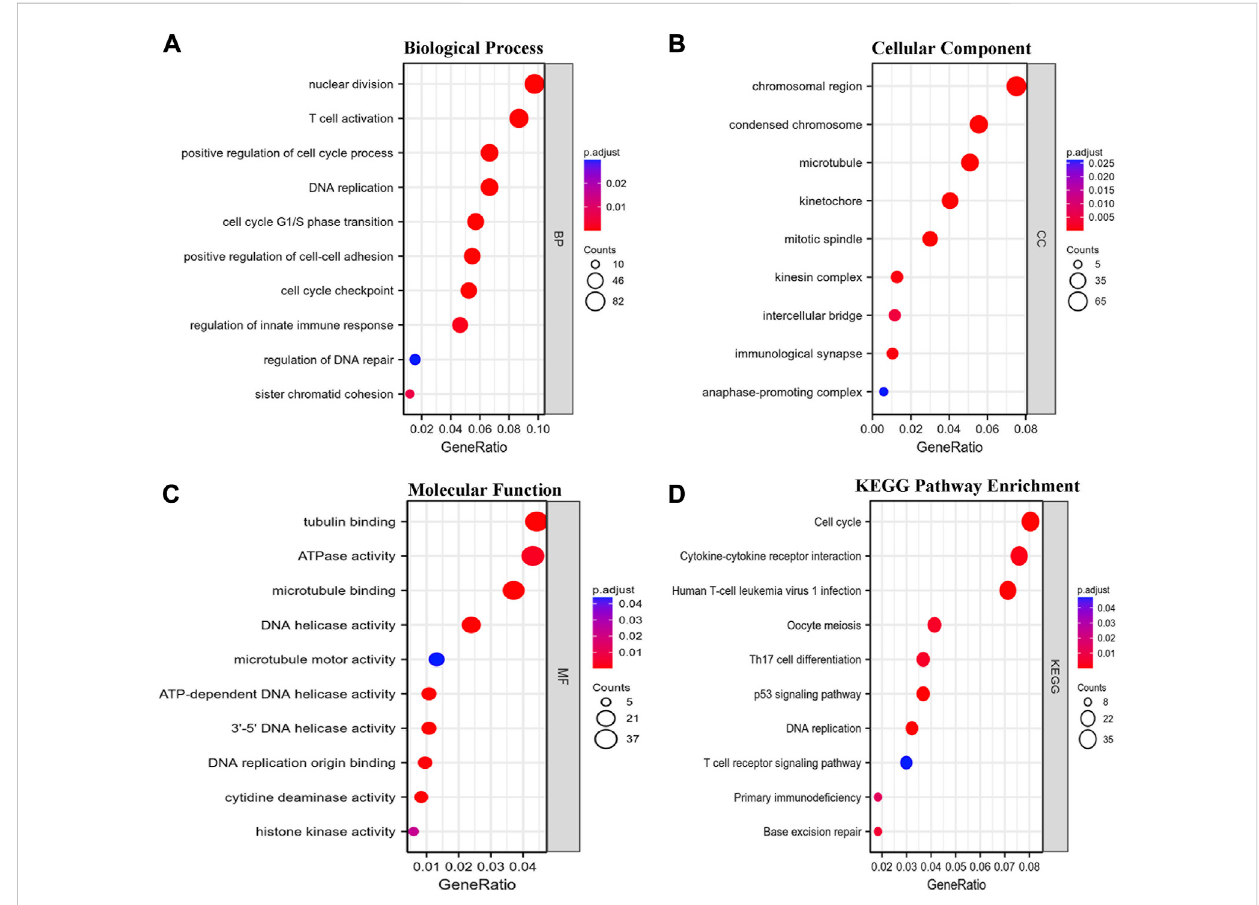
FIGURE 6 Functional enrichment analysis. GO annotation including biological process (BP) (A) , cellular component (CC) (B) , and molecular function (MF) (C) andKyotoEncyclopediaofGenesandGenomes(KEGG) (D) pathwayenrichmentanalysesbasedonthecoexpressedgenesofGTSE1wereclustered,and the top 10 terms of each subtype are displayed in the bubble